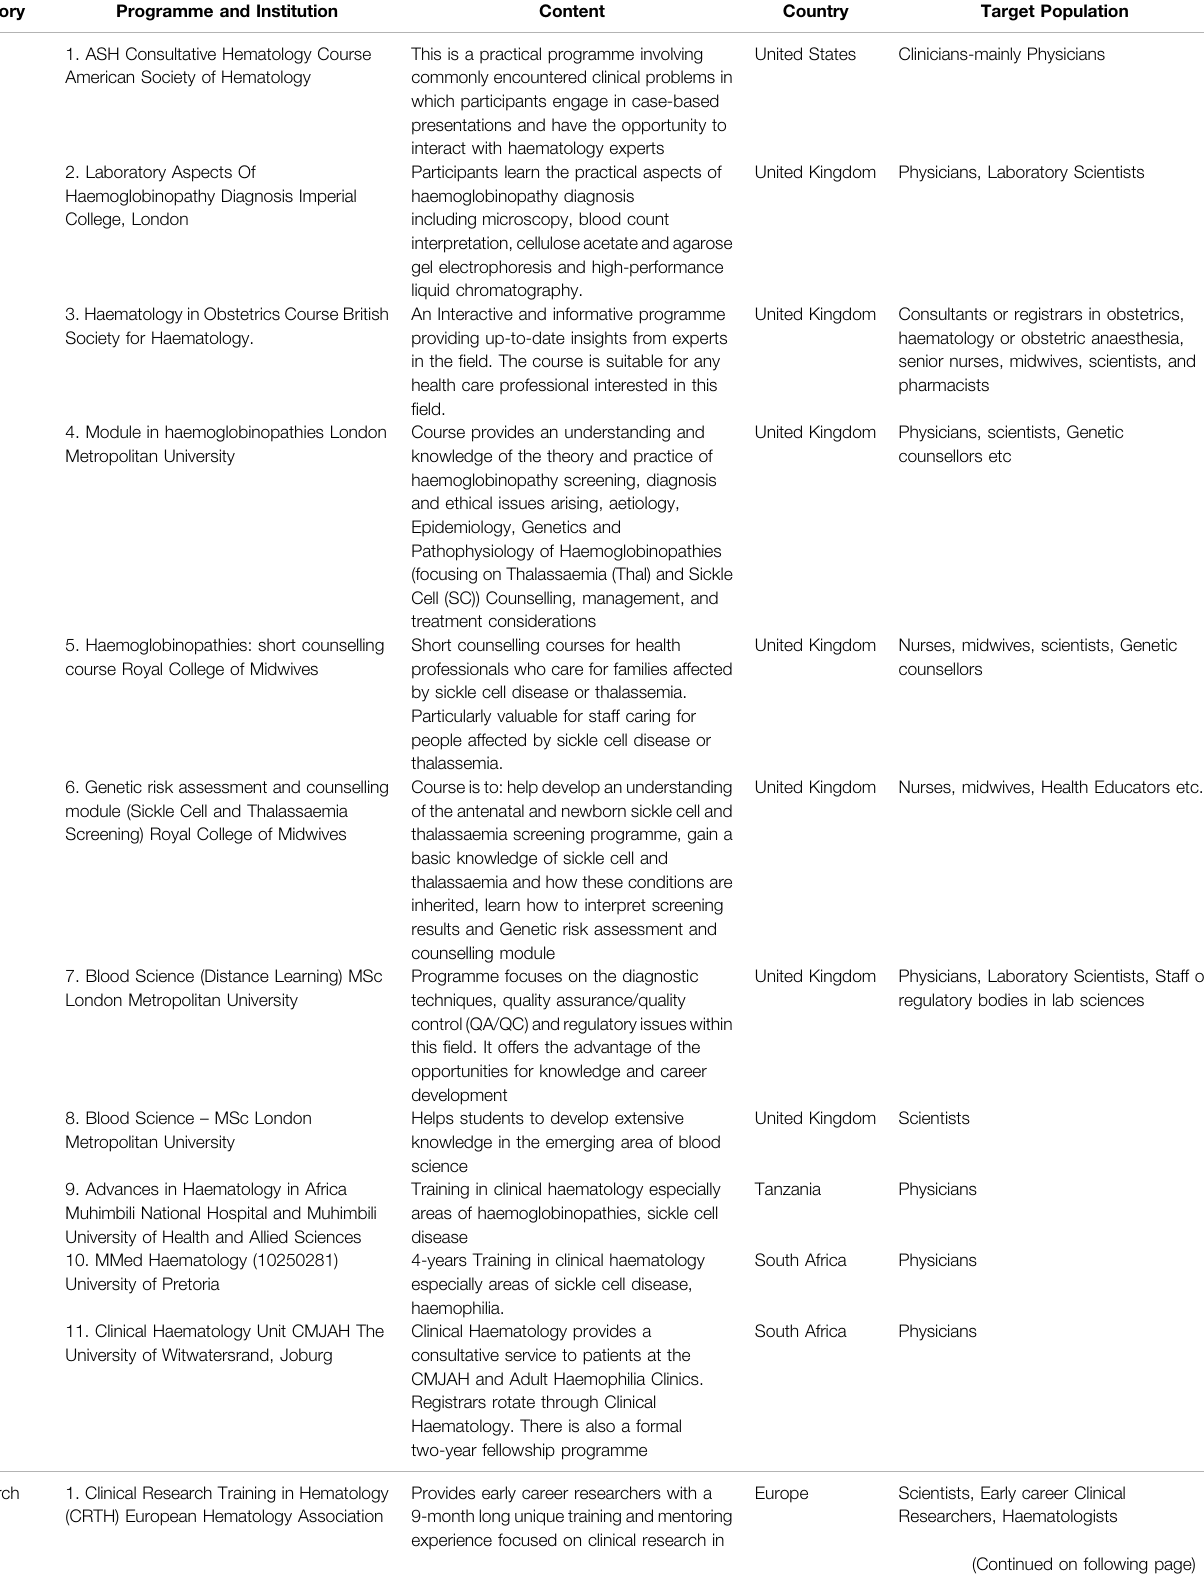
TABLE 2 | Selected courses identi fi ed in priority